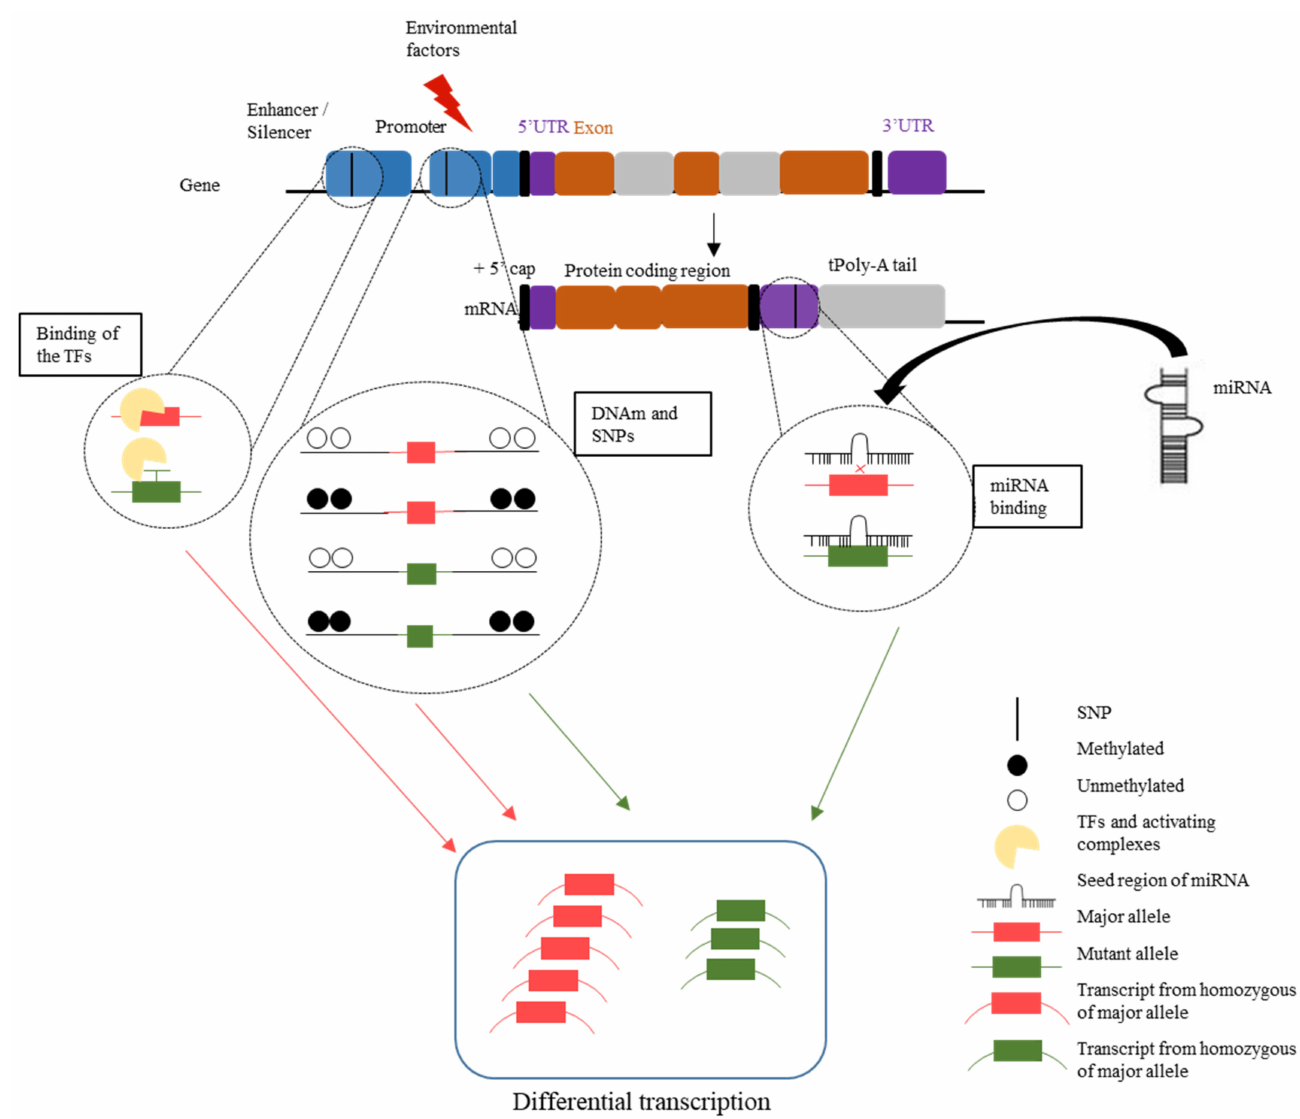
Figure 4. The interplay of SNPs, TFs, DNAm, and miRNA binding, leading to differential mRNA gene expression. SNPs, single-nucleotide polymorphisms; TFs, transcription factors; DNAm, DNA methylation; miRNA, microRNA. Reprinted/adapted with permission from ref. [19]. 2022, Diana M.